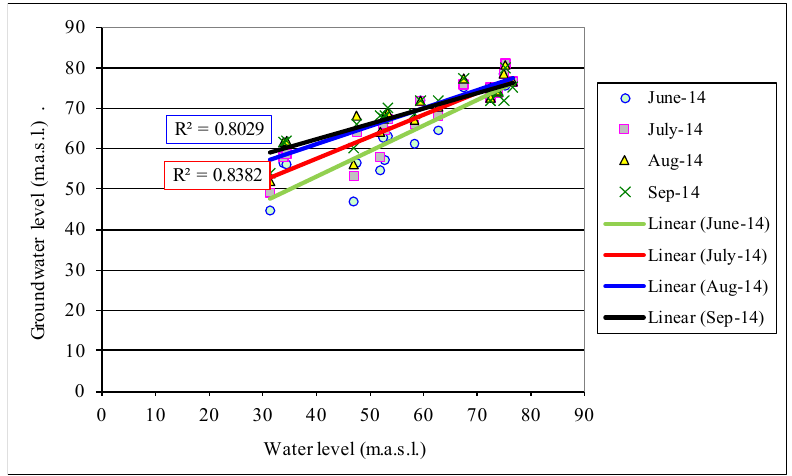
Figure 15. Coefficient of determination of parameters during the second period (May-Sept. 2014).